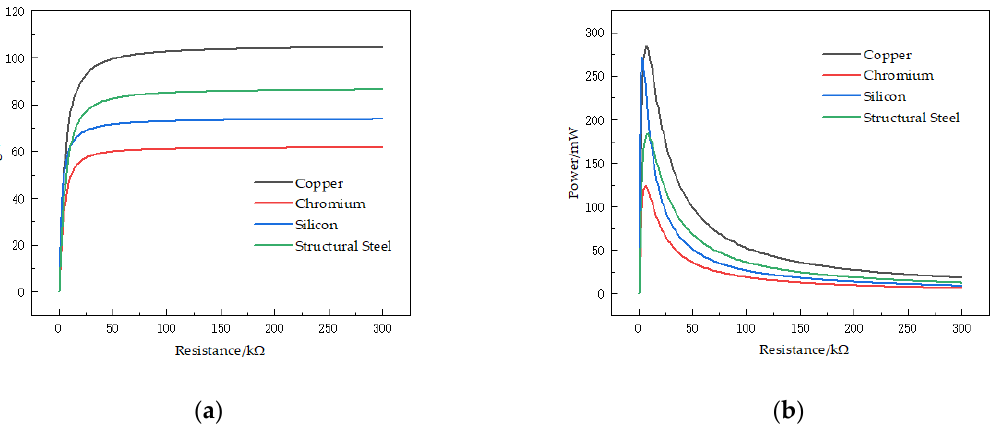
Figure 6. Output performance–resistance curves of the STTM-PEH under different substrate materials. ( a ) Output voltage–resistance curves. ( b ) Output power–resistance coefficient curves.